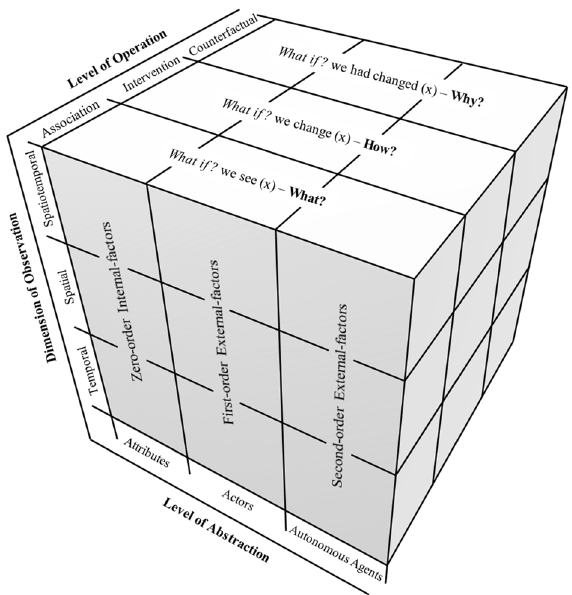
levels of causal analysis, from 46